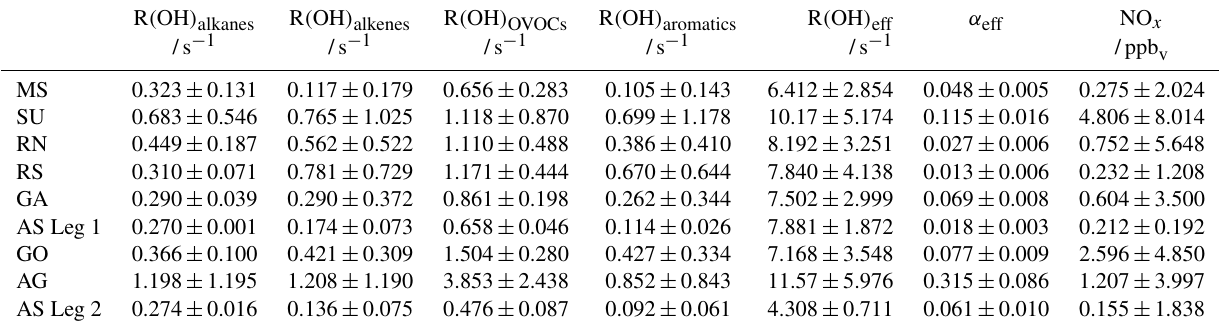
Table 1. Average speciated reactivity (R ( OH ) x ± 1 σ standard deviation) of certain compound classes (based on the results of Pfannerstill et al., 2019), R ( OH ) eff and α eff ( ± uncertainty of the slope of the bivariate fit). For NO x , the median values are listed instead of the means. R ( OH )